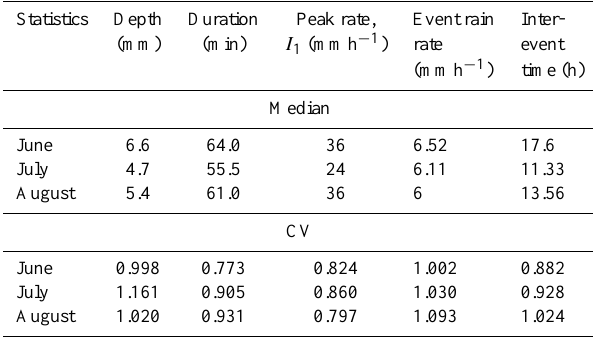
Table 3. The temporal variation of the median of rain event proper- ties at Jema for MIT=30min. The events are observed in two wet seasons that are JJA 2007 and